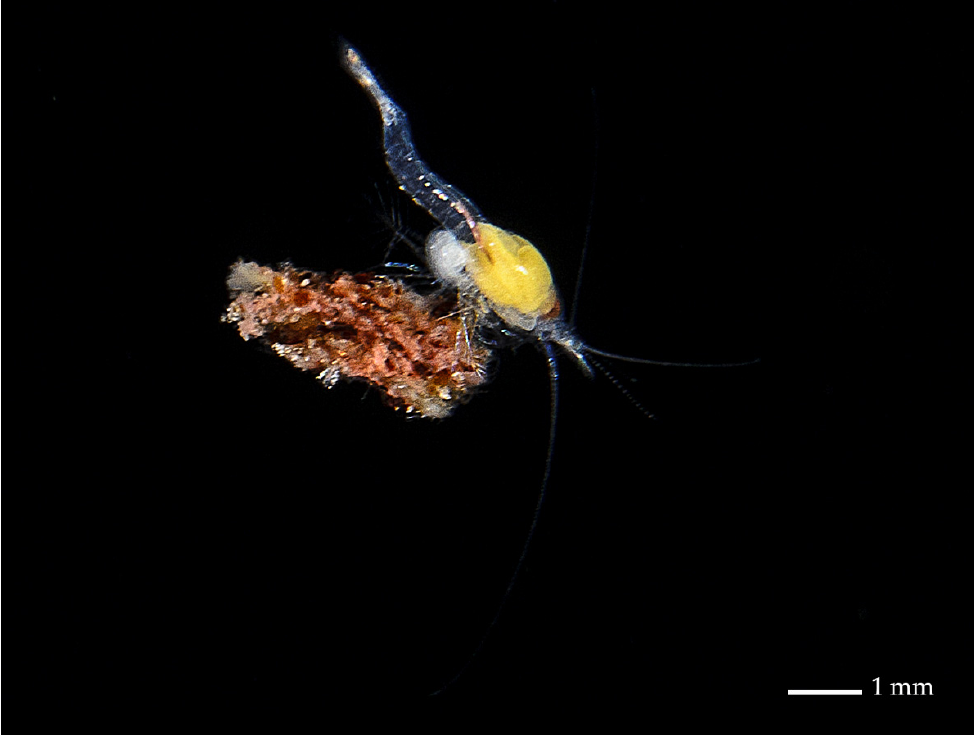
Figure 1. A. cenotensis holding a piece of organic detritus, typically observed during raptorial feeding. Cenote Kanún, Homún at 17 m in depth in September 2017. Photography courtesy of Benjamín Magaña-Rodríguez.